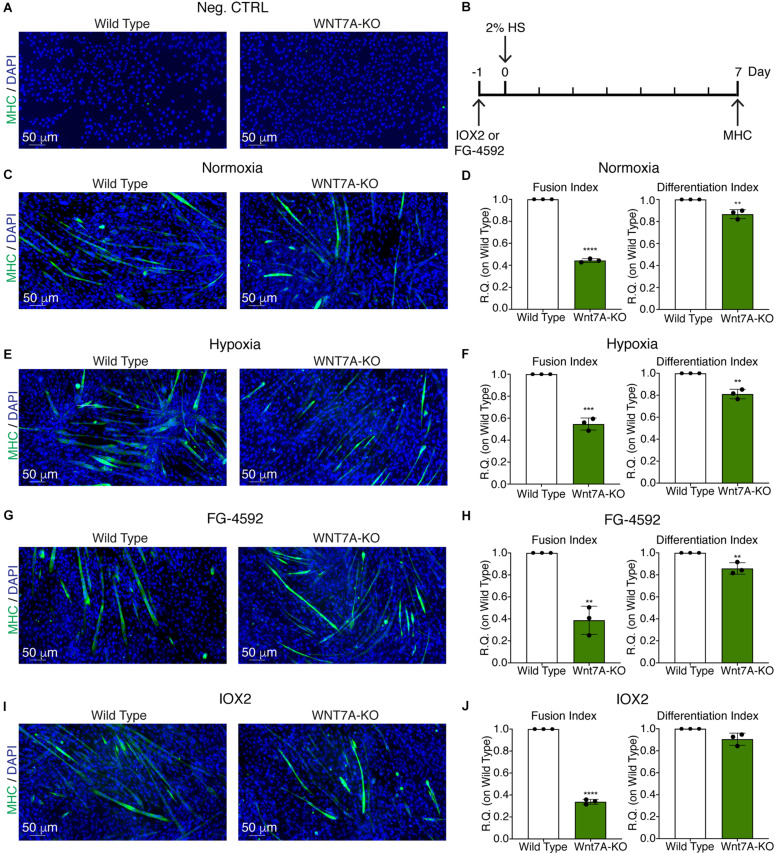
Effects of WNT7A inhibition on skeletal muscle differentiation upon physical and pharmacological hypoxia. (A) Negative control of myosin heavy chain (MHC) staining in proliferation wild type (WT) and WNT7A-silenced murine myoblasts (WNT7A-KO). (B) Schematic representation of MHC staining at 7 days of the differentiation process. (C,E,G, I) Immunofluorescence staining of MHC (green) in WT and WNT7A-silenced murine myoblasts (WNT7A-KO) treated under normoxia (C), hypoxia (E), FG-4592 (G), or IOX2 (I) for 24 h in GM and then switched to differentiation medium (DM) without the prolyl-hydroxylases (PHDs) inhibitors for 7 days. Nuclei were stained with Hoechst 33342. Magnification is 200× (n = 3). (D,F,H,J) Quantification of the fusion index, as the ratio between MHC-positive nuclei and the total number of nuclei, and of the differentiation index, as the ratio between myotubes area and MHC-positive nuclei at the end of differentiation (n = 3). Data information: all data represent mean ± SD. **p < 0.01, ***p < 0.001, ****p < 0.0001 (Student’s t-test).